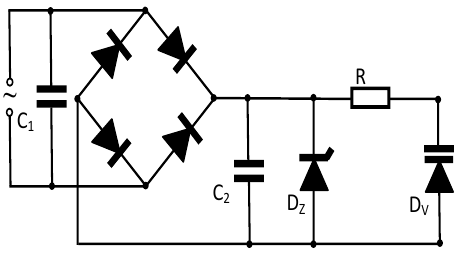
Figure 4. Rectifying